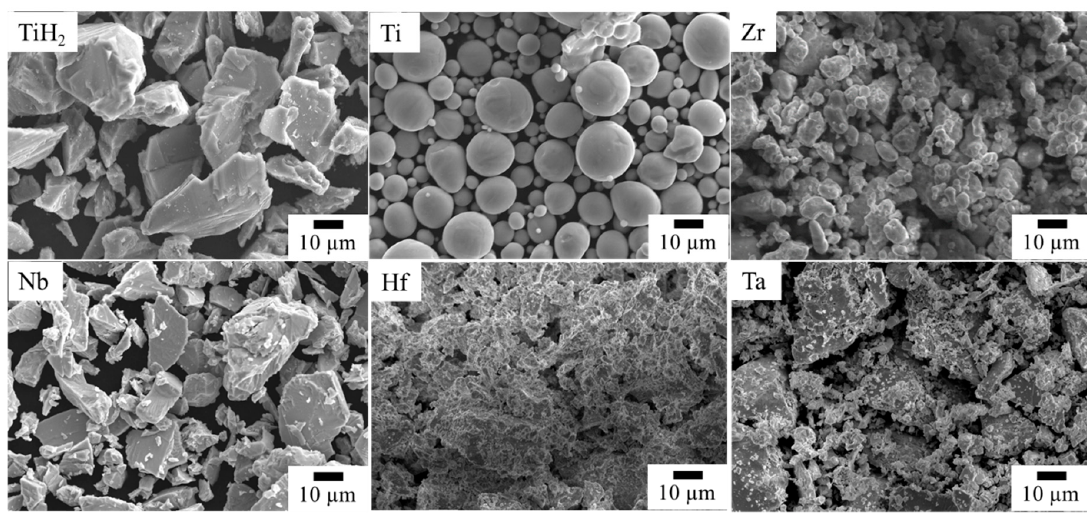
Figure 1. SEM micrographs of the starting powders.